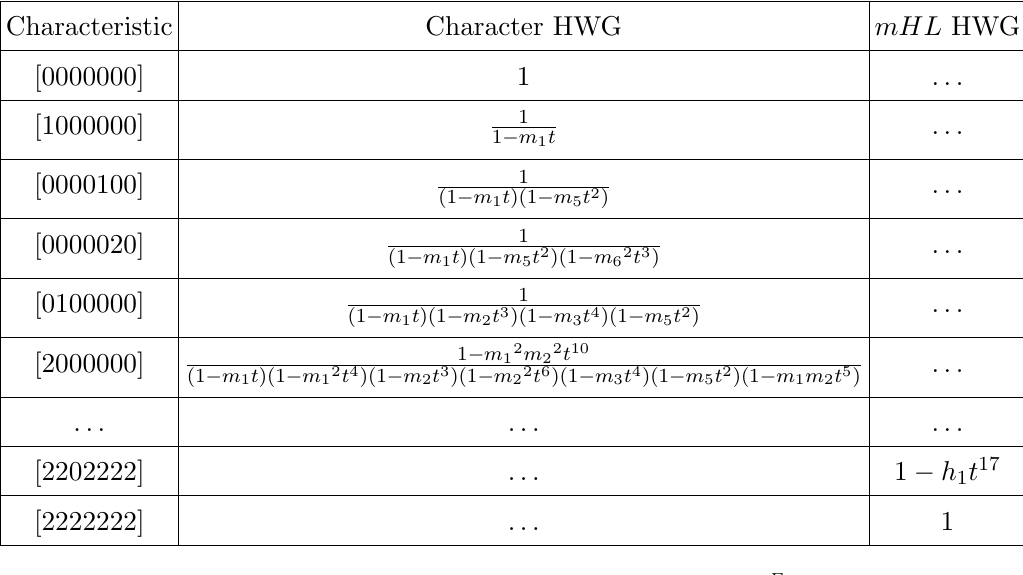
Table 30 . E 7 orbits and HWGs. An mHL HWG of 1 denotes mHL E 7 centre of the Hasse diagram are omitted.